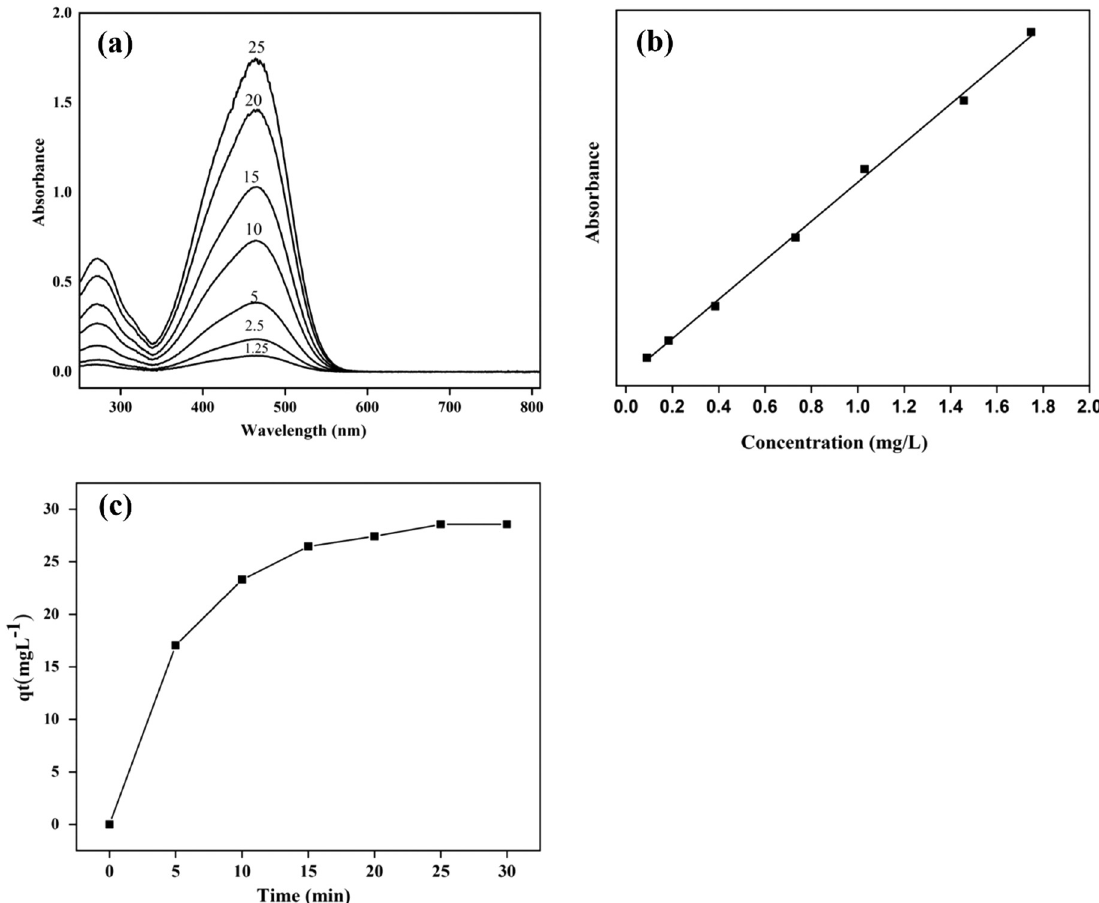
Figure 4: ( a ) UV - visible spectra of di ff erent concentrations ( mg/L ) of the MO solution, ( b ) linear fi t, and ( c ) kinetics of MO adsorption on CH - g - POEA.